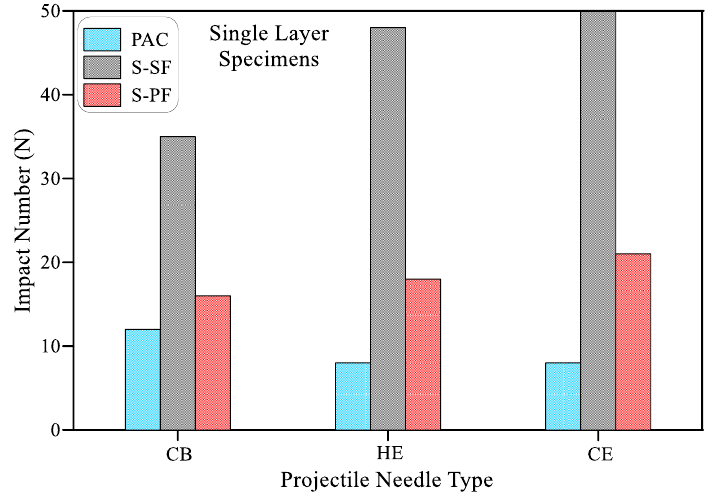
Figure 10. Effect of fibre type on the failure impact number (N) of the projectile impact test.